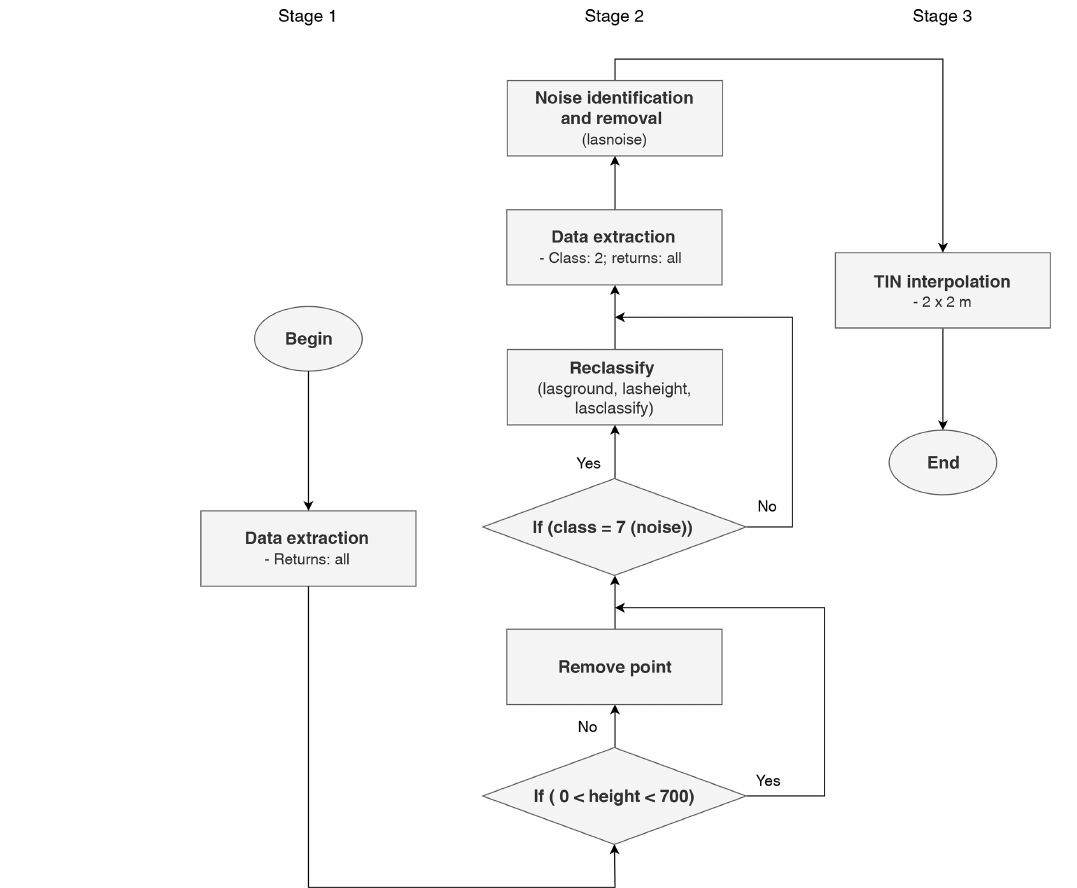
Figure 2. Workflow diagram for producing the terrain map using